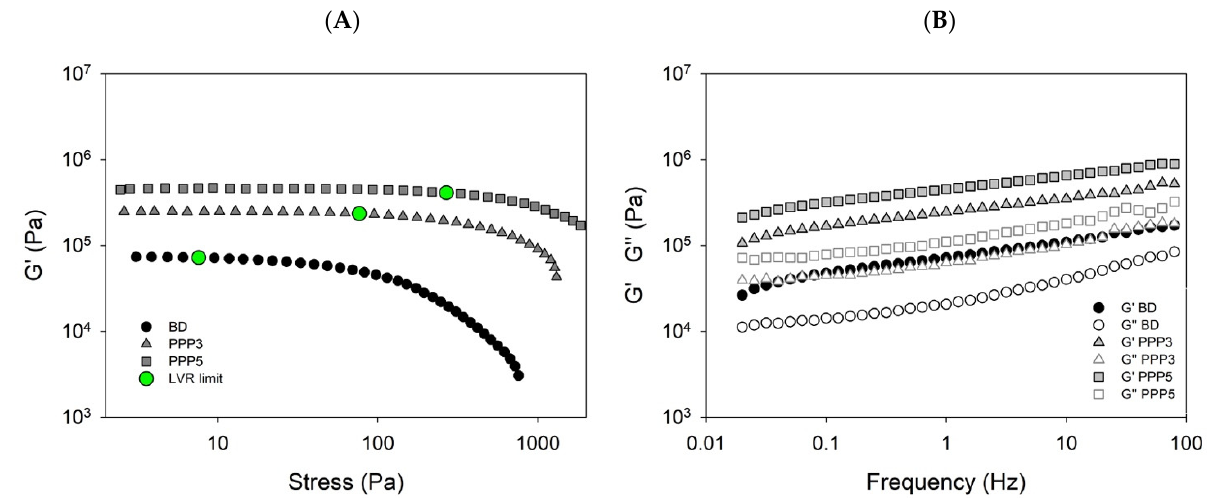
Figure 6. Rheological behavior of the raw doughs: ( A ) G’ vs. applied stress for the reference dough (BD) and the doughs containing the pomegranate peel powder at a concentration of 3 (PPP3) and 5 (PPP5) wt%. The full green dots show the stress values limiting the linear viscoelastic region. ( B ) Mechanical spectra illustrating the profiles of the elastic, G’ (full symbols), and viscous, G” (empty symbols), moduli as a function of the frequency for P3 (triangles) and P5 (squares) samples compared to the blank dough (circles).